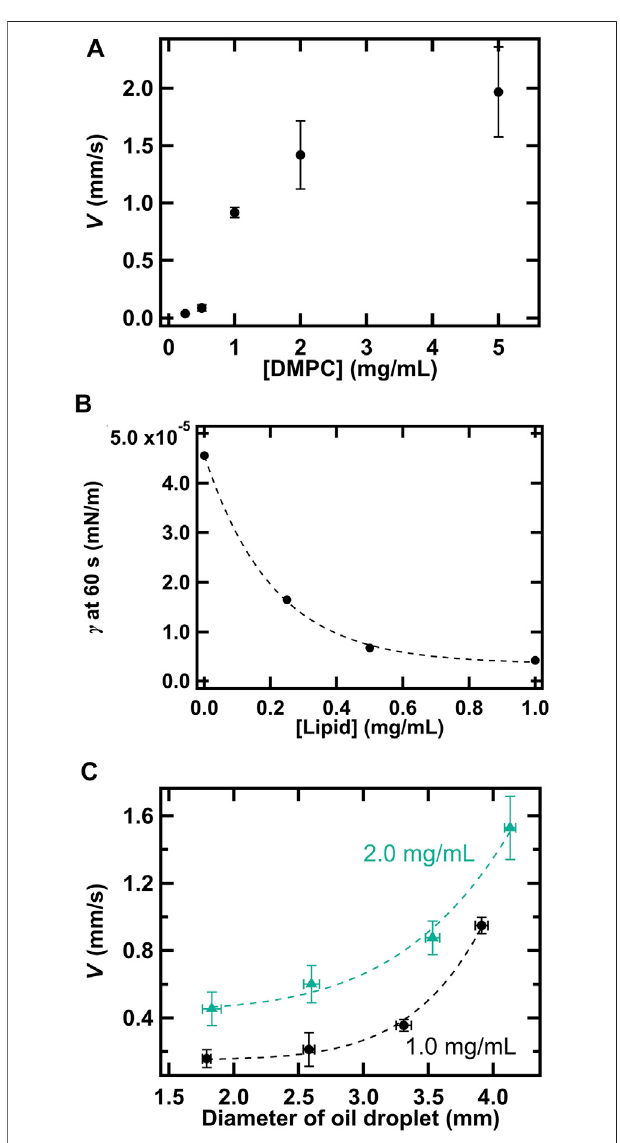
FIGURE5|(A) Effects ofDMPCconcentration(0 – 5.0 mg/ml)on V ([I 2 ]= 1.0 mM and [TSAC] = 1.0 mM). (B) Measured γ at 60 s for droplets with different DMPC concentrations ([I 2 ] = 1.0 mM and [TSAC] = 0 mM). (C) Variation in V with the diameter of the droplet at [DMPC] = 1.0 and 2.0